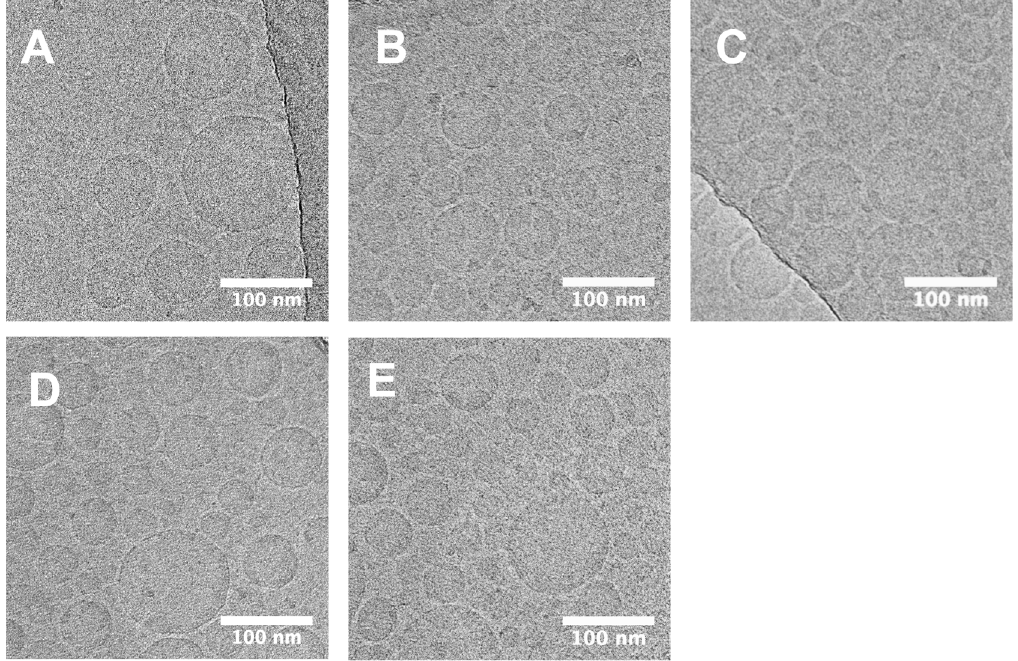
Figure 2. Cryo-EM images show no qualitative difference between AddaS03-like emulsions and those containing INI-4001 or INI-2002 alone or in combination. Cryo-EM was used to determine qualitative differences between ( A ) AddaS03-like emulsions and AddaS03-like emulsions containing ( B ) INI-4001 at 1.75 mM, ( C ) INI-2002 at 1.75 mM, and combinations of INI-4001 and INI-2002 at ( D ) 1.75 mM and 0.175 mM, respectively, and ( E ) 1.75 mM and 1.75 mM, respectively. Images were taken at 22,000× magnification with scale bars indicating 100 nm. Images are representative of each emulsion.